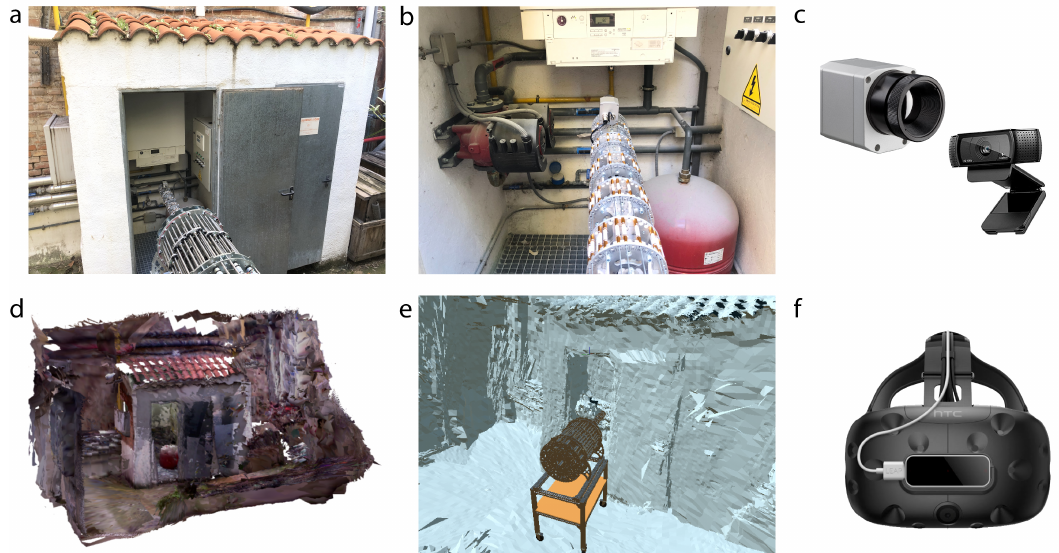
Figure 12. ( a ) Boiler room with the robot prepared to perform an inspection. ( b ) First-person view of the robot and the thermal camera located in the end-effector. ( c ) Two sensors were used in the real environment: an Optrix PI thermal camera and a Logitech RGB camera. ( d ) On the other hand, the real scenario was reconstructed using a Kinect and the software RTAB-Map. ( e ) Then, it was imported in Virtual Reality with a model of the robot. ( f ) The operator uses the HTC Vive VR headset and the Leap Motion controller to teleoperate the real robot from a remote and safe